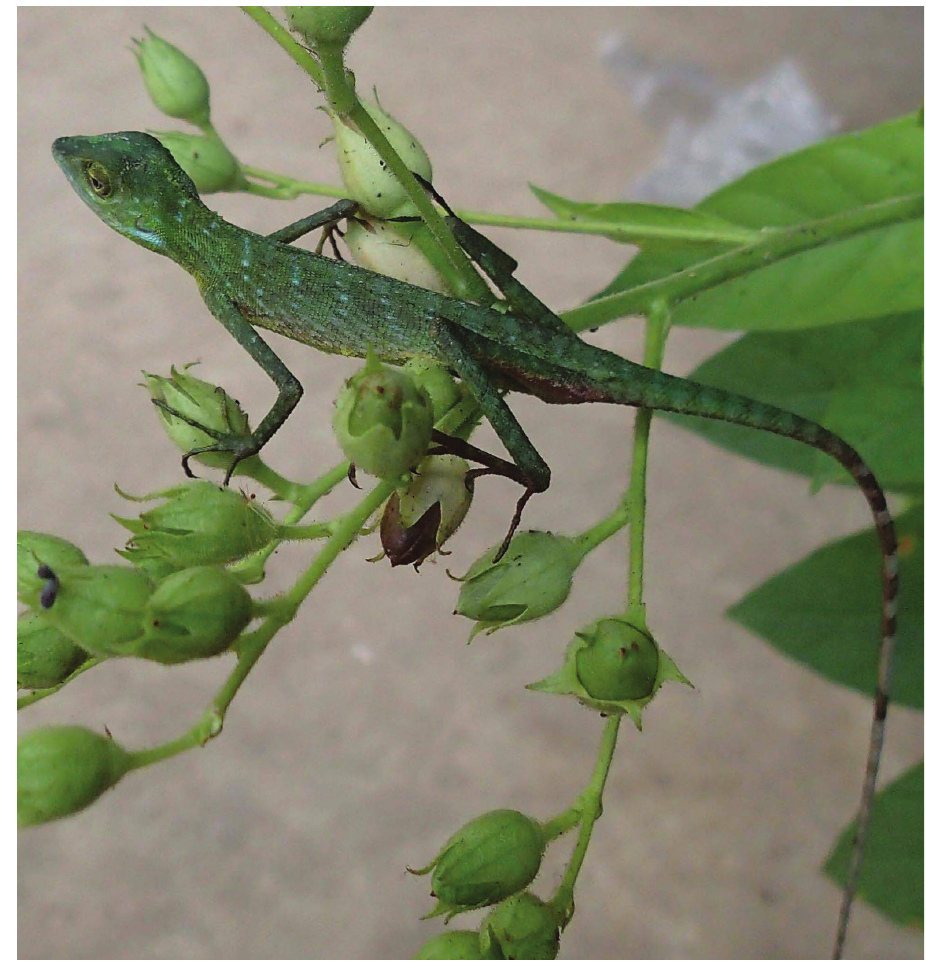
Figure 3. Bronchocela burmana Blanford, 1878 from the Lenya area (circa 11.68N 99.42E). A dorsolat- eral view of a living Burmese Crested Lizard, USNM 587483. Photo by